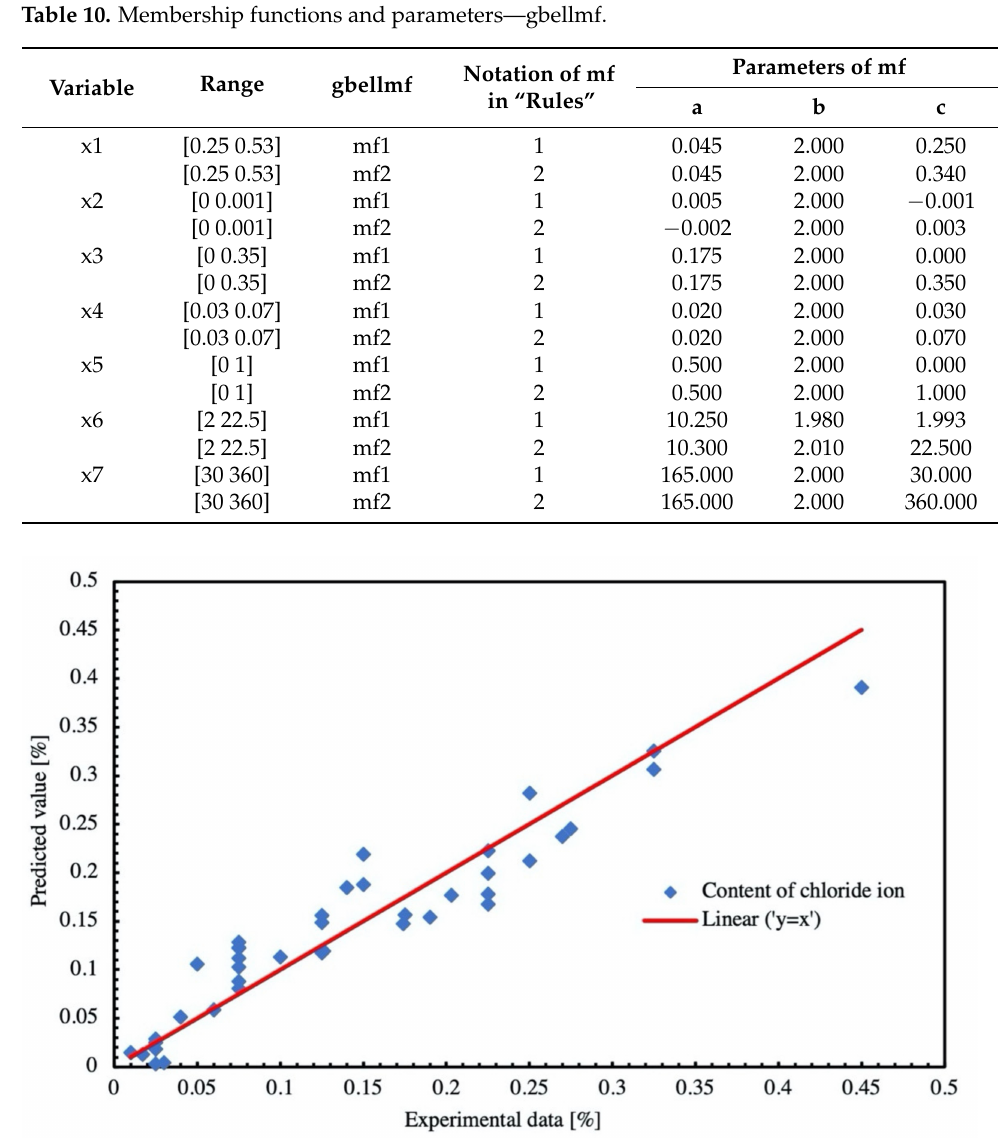
Figure 18. Performance of testing of ANFIS